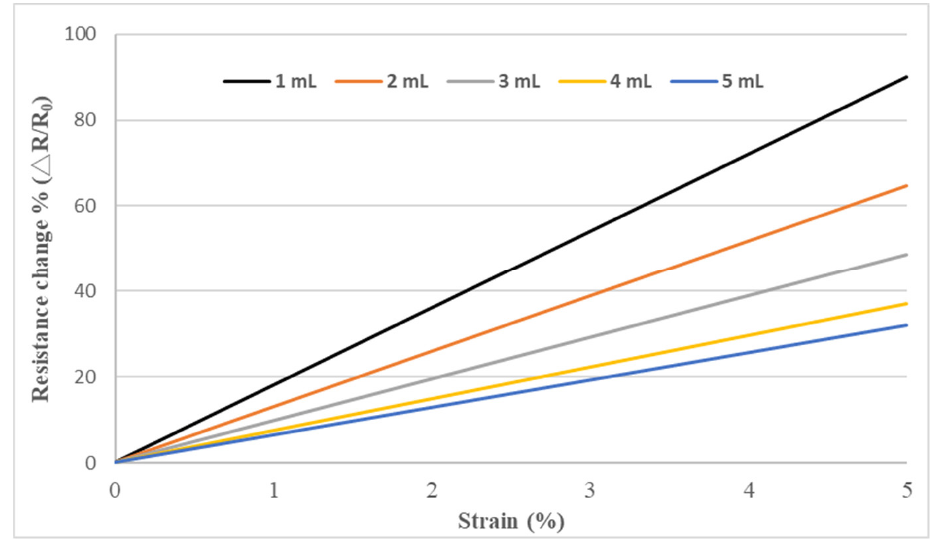
Figure 8. Resistance change vs. applied strain of the hybrid nanomaterial film with a fixed GNP content of 50 wt.% while the spray volume increased from 1 mL to 5 mL. Table 3. Gauge factors of hybrid nanomaterial films with various spray volumes and GNP